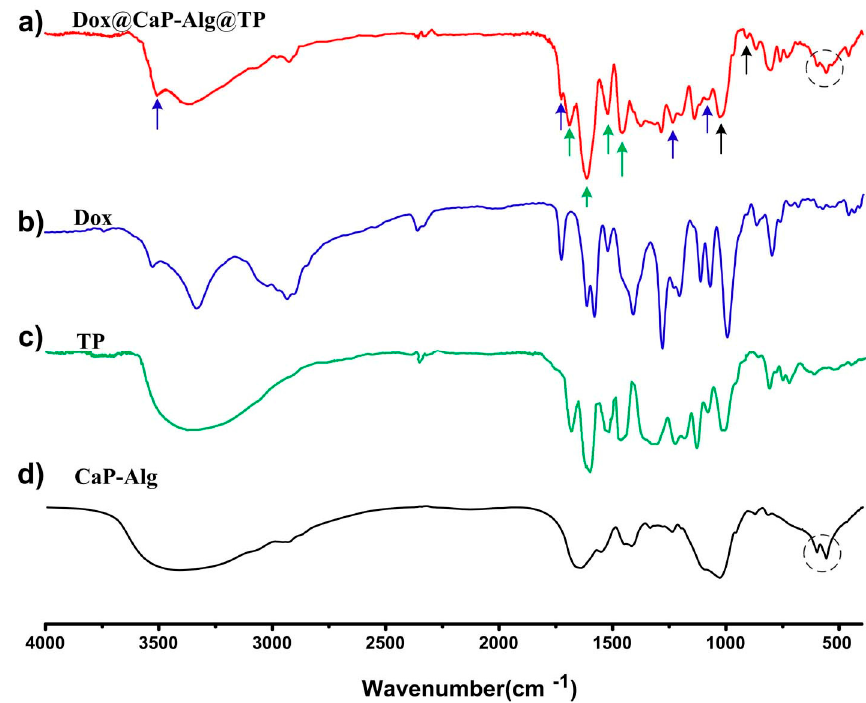
Figure 4. Fourier transform infrared spectroscopy (FTIRI spectra of the samples: ( a ) DCAT nanospheres; ( b ) Dox; ( c ) tea polyphenols (TP), and ( d ) CaP-Alg.